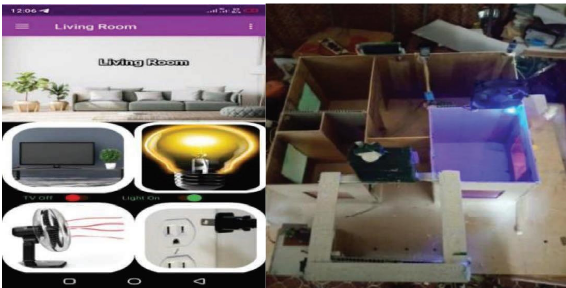
Figure 9: Controlling lights in the room with an Android app.